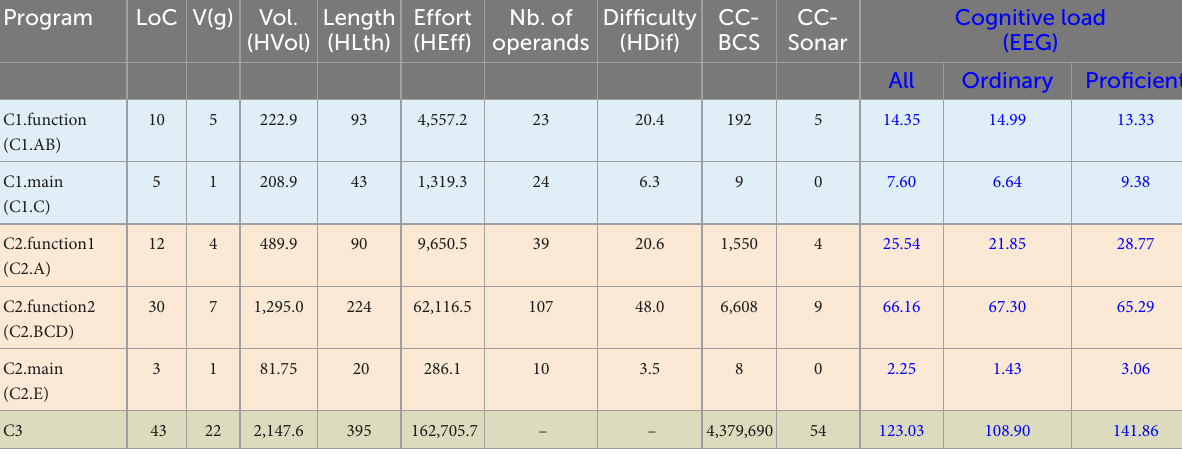
TABLE 7 Code of the main units of C1 and C2, showing that even small differences in the code could lead to different average cognitive load measured by EEG. Program C1, main V(g) = 1 CC-Sonar = 0 / Cognitive Load (EEG) =